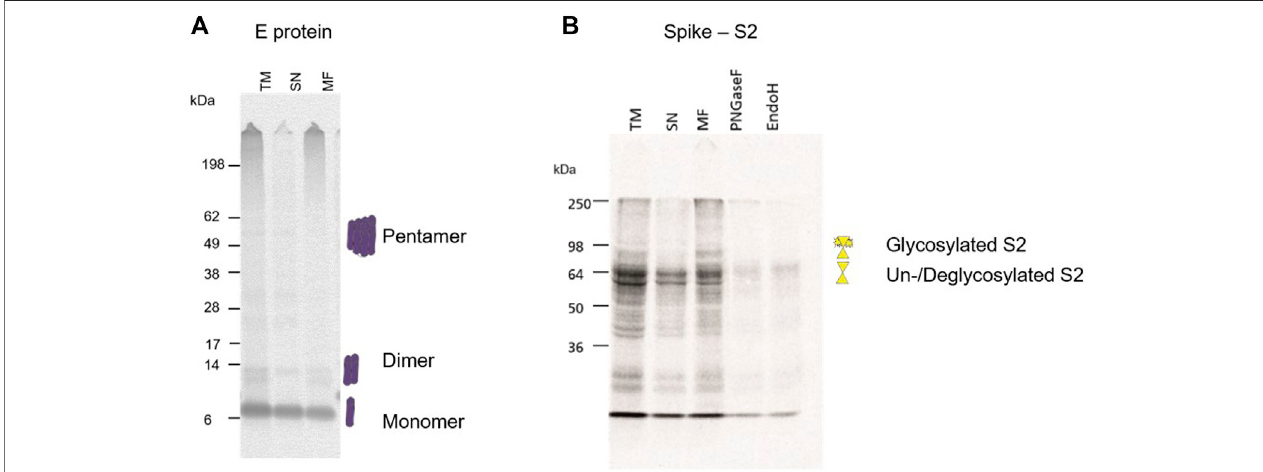
FIGURE 5 | Structural protein analysis of E and S2. (A) Autoradiograph showing the envelope protein synthesized in a CHO cell-free system showing multimerization. The translation mixture (TM) was separated into the soluble proteins in the supernatant (SN) and the microsomal fraction (MF). (B) Autoradiograph showing the S2 domain from the Spike protein synthesized in a CHO cell-free system. The translation mixture (TM) was separated into the soluble proteins in the supernatant (SN) and the microsomal fraction (MF). The MF was digested with PNGaseF and EndoH.